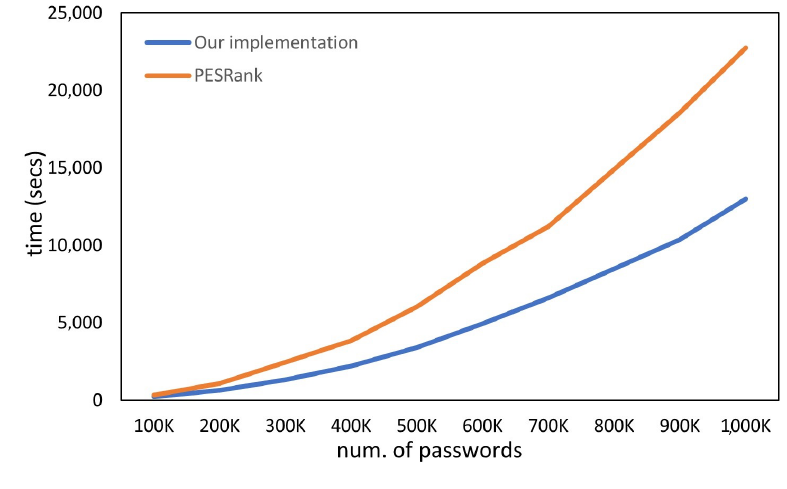
Figure 3. Our password guessability estimator component vs. PESRank (100 k–1000 k). The x-axis represents the number of passwords in the input dataset, while the y-axis represents time in seconds.